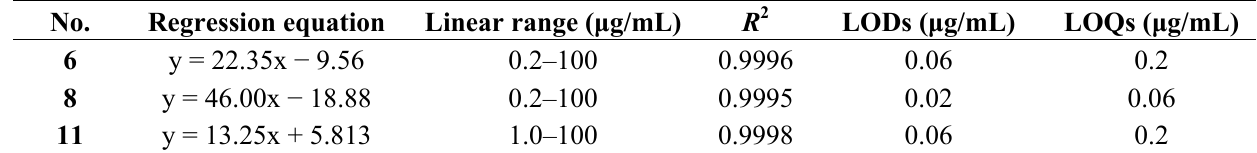
Table 2. Calibration parameters of UPLC-MS analysis for the three